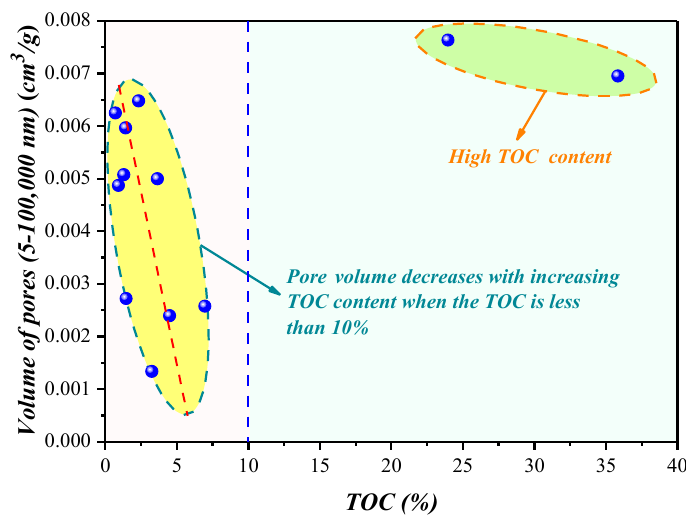
Figure 12. Relationship between volume of pores (5–100,000 nm) by the high-pressure Hg injection experiment and TOC content.